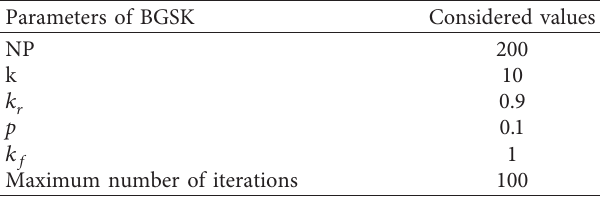
Table 11: Optimum solutions for the 30 simulation